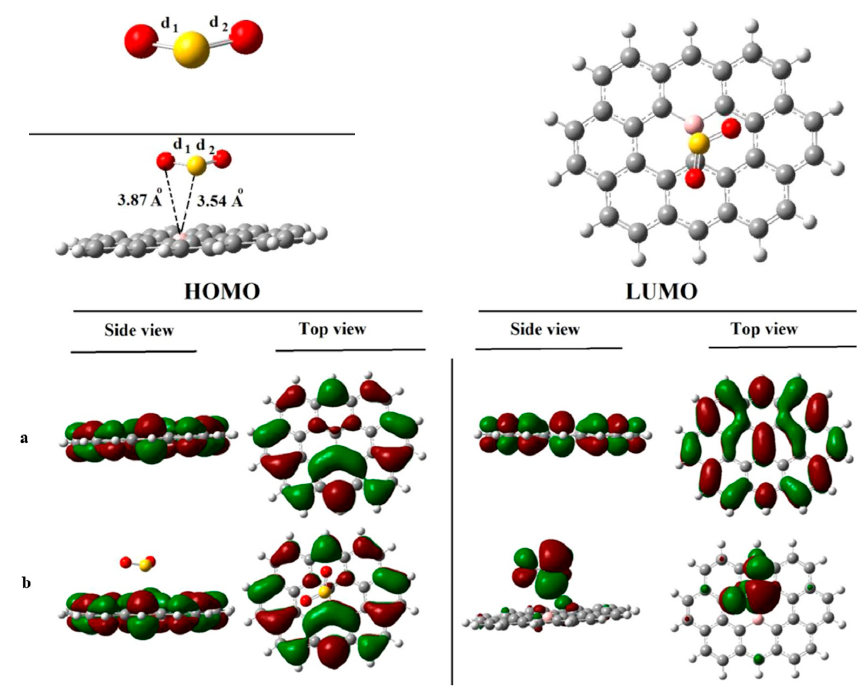
Figure 2. Adsorption configuration and orbital distributions for SO 2 adsorbed on B-graphene. ( a ) isolated B-graphene; ( b ) B-graphene/SO 2 . Reproduced with permission from [55]. Copyright 2016 Journal of Solid State Chemistry.